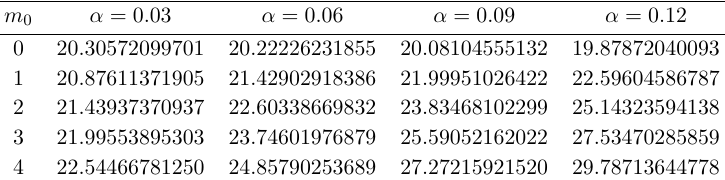
Table 8 . Angular eigenvalues λ with ‘ = 4 of the accelerating Schwarzschild AdS black hole with 3 r h = Λ = − 3 .